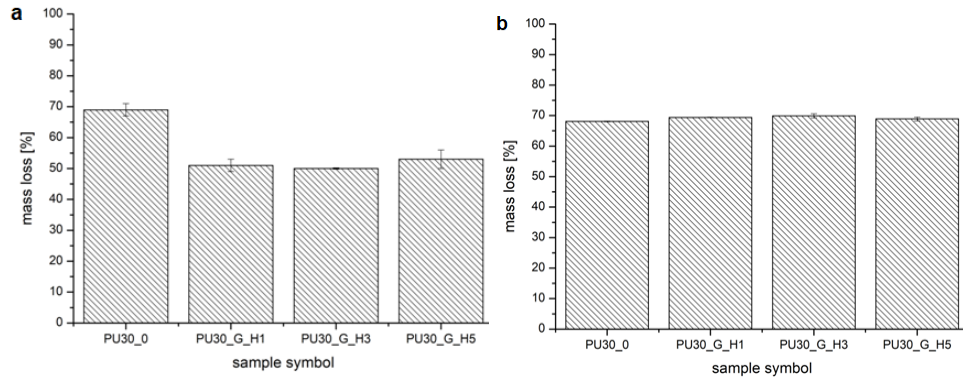
ff olds after incubation in ( a ) 5 M KOH and ( b ) 2 M Figure 11. The mass loss of the scaffolds after incubation in ( a ) 5 M KOH and ( b ) 2 M HCl. Figure 11. The mass loss of the sca